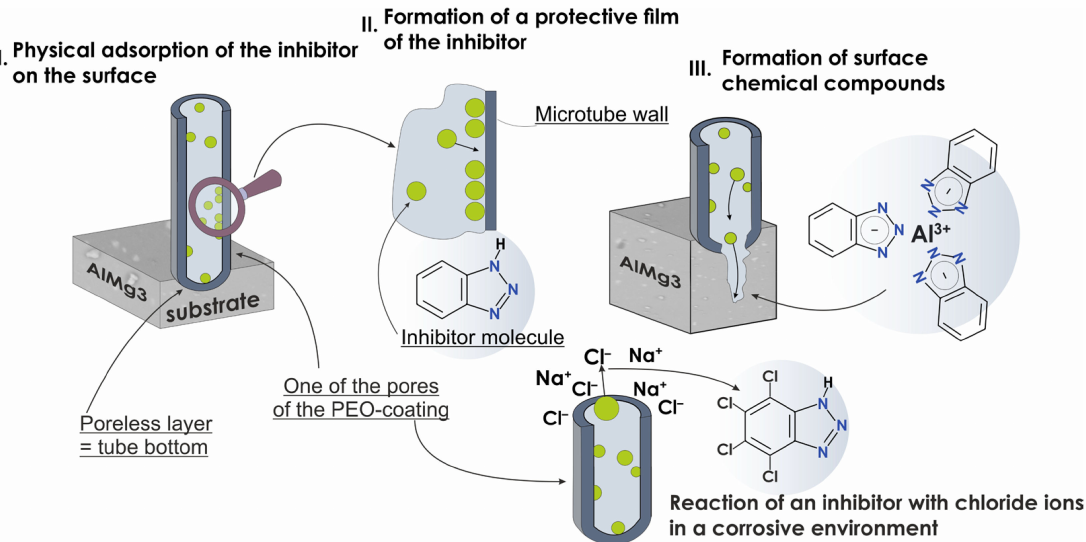
Figure 15. The mechanism of the protection against corrosion of the aluminum alloy sample with azole-containing PEO-layer in the presence of chlorine ions. Benzotriazole was used as an example of the action of the corrosion